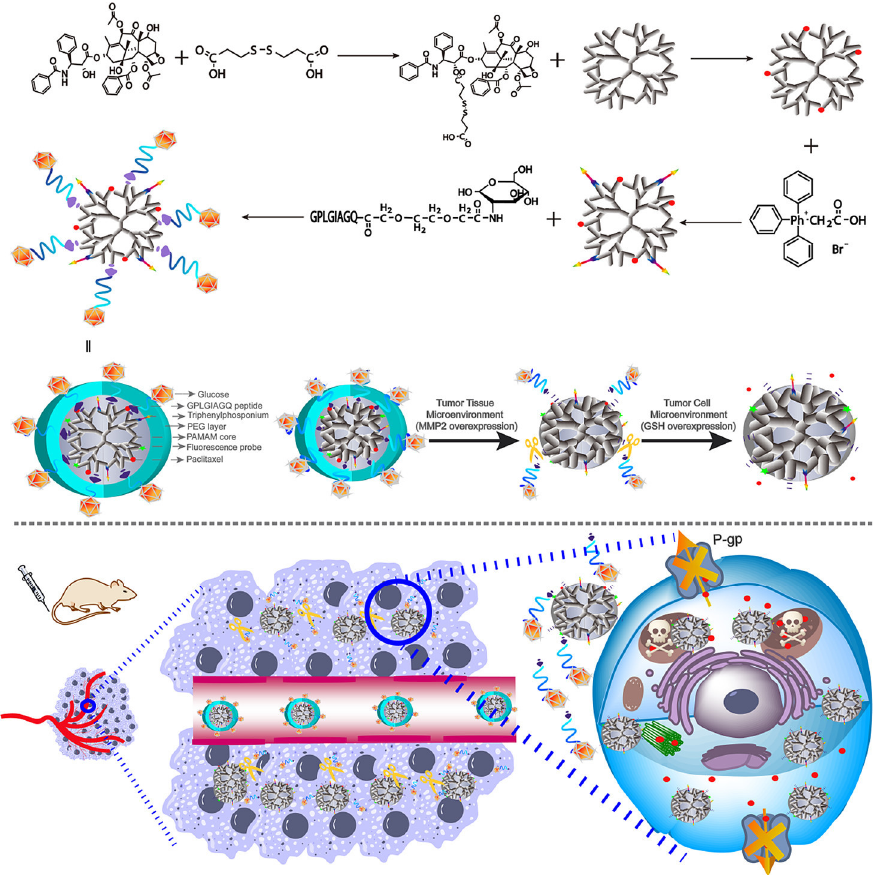
Figure 5. Schematic illustration of the synthesis route of the glucose-PEG–peptide–triphenylphosponium–PAMAM–PTX conjugate and its action mechanism of overcoming multidrug resistance. Abbreviation: PTX: paclitaxel. Reprinted with permission from ref. [171]. Copyright © 2018 American Chemical Society.